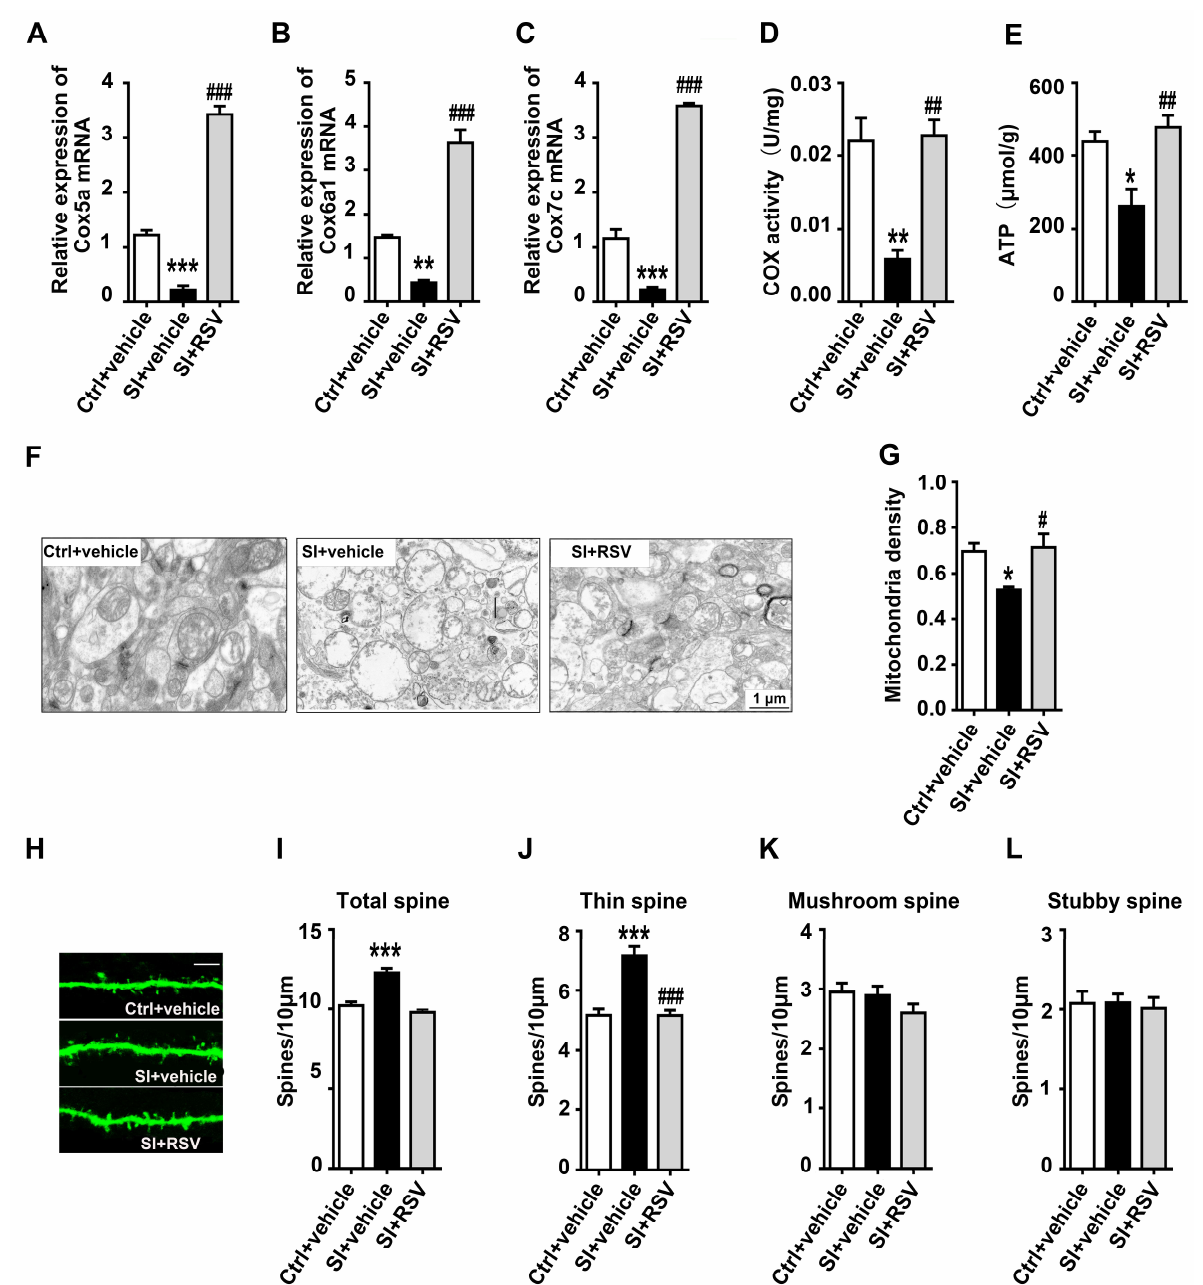
Figure 5. The protective effects of resveratrol on adolescent social-isolation-induced mitochondrial and spine abnormalities in female rats: ( A – C ) resveratrol treatments significantly increased the mRNA levels of Cox5a, Cox6a1 and Cox7c in the NAc compared with vehicle-treated isolated rats; ( D ) resveratrol treatments increased the activity of cytochrome C oxidase in the NAc; ( E ) resveratrol treatments increased the ATP content in the NAc; ( F ) representative electron micrographs among all groups; scale bars = 1 μm; ( G ) resveratrol increased the number of mitochondria in the NAc; ( H ) images of dendritic segments taken with confocal microscopy; scale bar = 5 μm; ( I , J ) resveratrol blocked the social-isolation-induced increase in the total and thin spine density compared with vehicle-treated SI rats; ( K , L ) no difference in mushroom and stubby spine density was observed among all groups; analyses were performed using one-way ANOVA followed by Bonferroni’s multiple comparison post hoc test; data were presented as mean ± SEM; *** p < 0.001; ** p < 0.01; and * p < 0.05 compared with the Ctrl +vehicle group; ### p < 0.001; ## p < 0.01; and # p < 0.05 compared with the SI+vehicle groups; Ctrl indicates control; SI indicates social